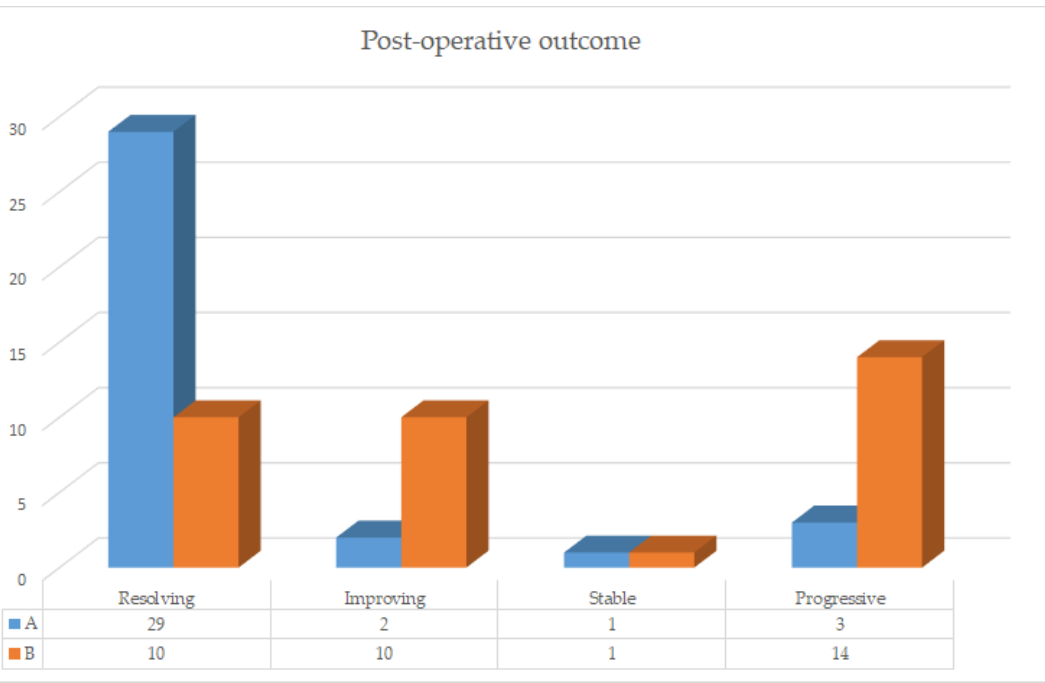
Figure 1. Post-operative outcome histograms group A vs. group B.